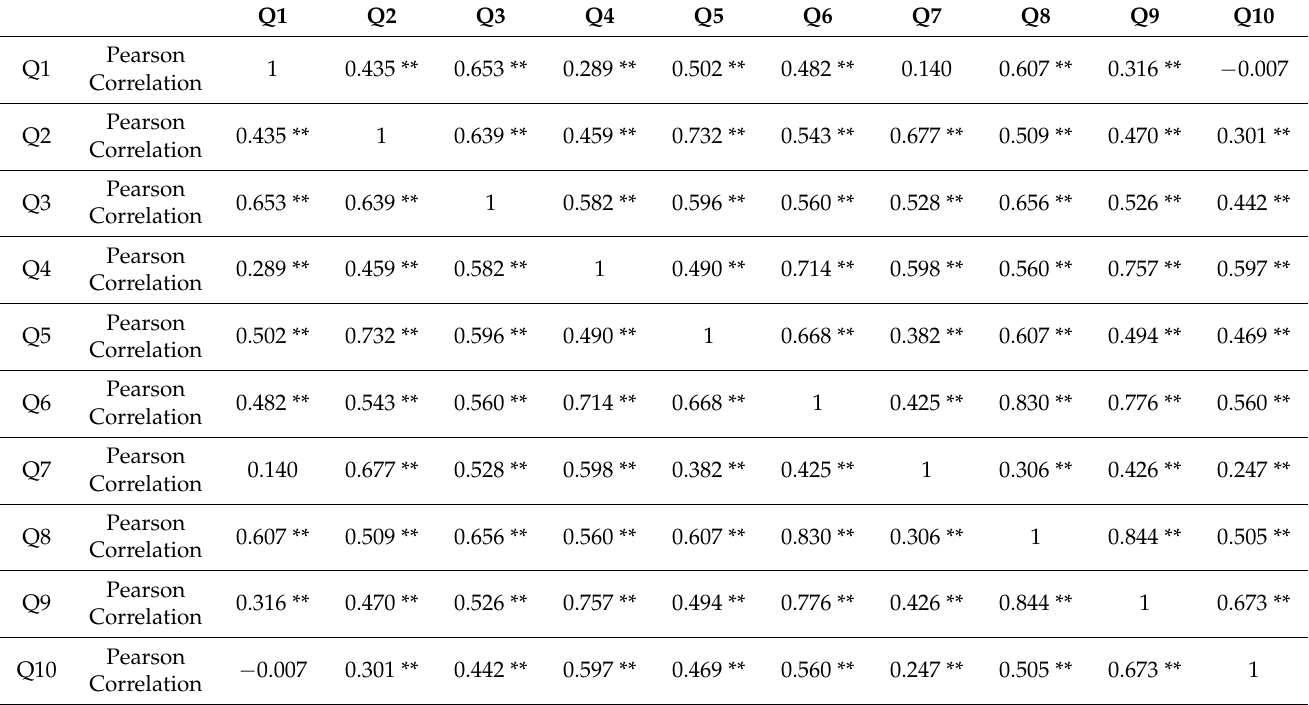
Table 2. Pearson’s Correlation results between the identified